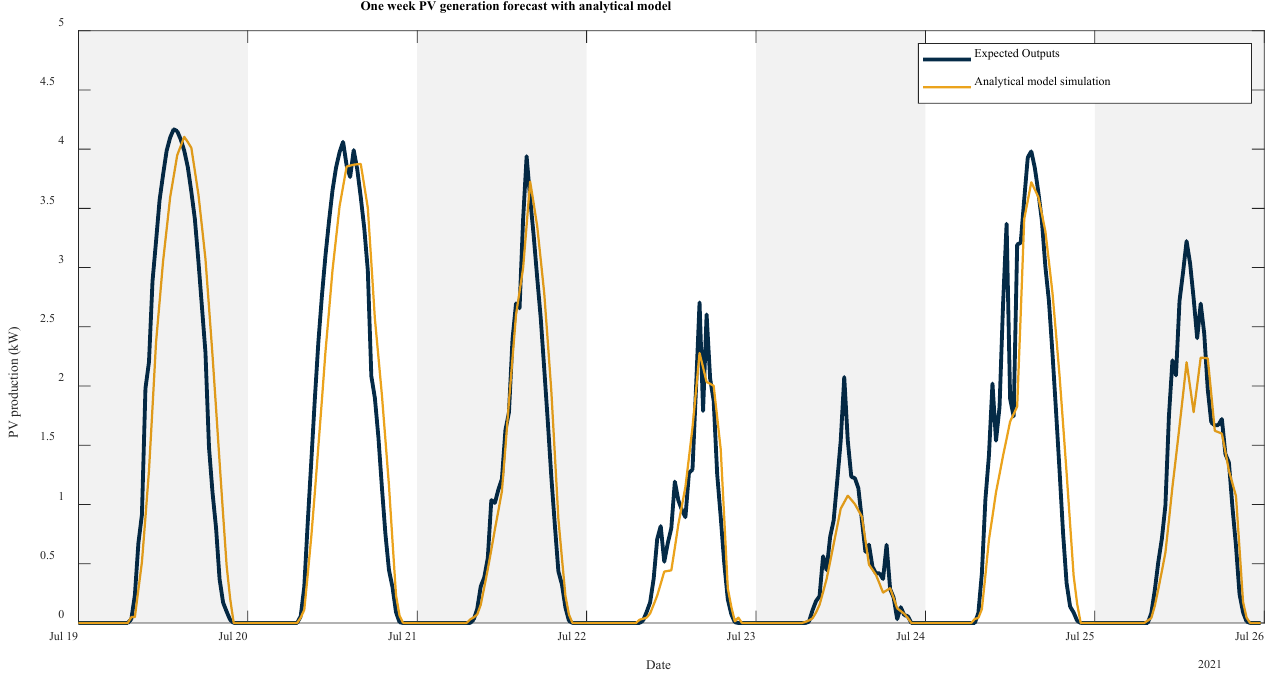
Figure 13. Forecast of PV generation for a week of July with SVR model.